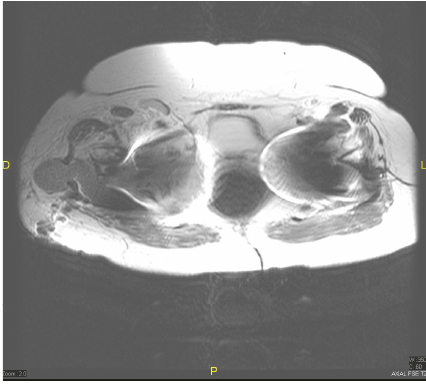
Figure 2: A preoperative right hip MRI. This is a T2 fat-sat weighted MRI axial cut showing the well-organized collection extending into the right prosthesis.